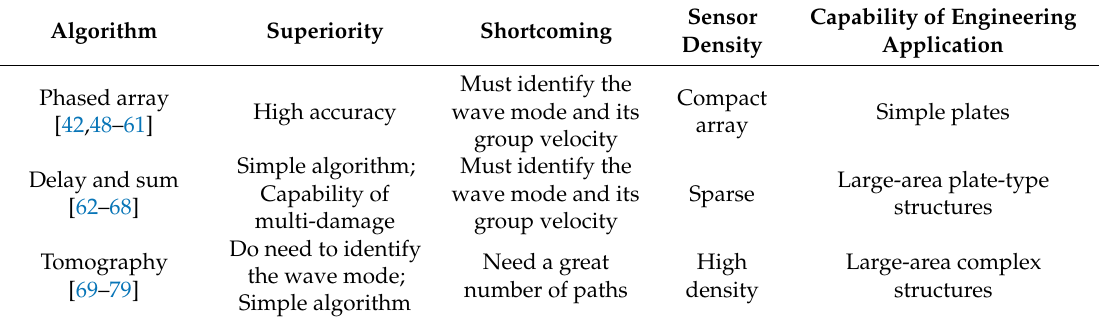
Table 3. Comparisons of several damage detection techniques for